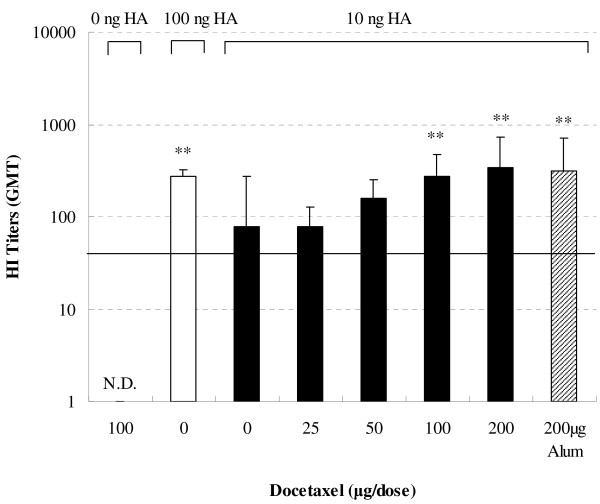
Serum HI titers. Mice (8 animals/group) were subcutaneously injected at weeks 0 and 3 with 100 μg docetaxel, inactivated H1N1 influenza virus antigen (equivalent to 10 or 100 ng HA) or inactivated H1N1 influenza virus antigen (equivalent to 10 ng HA) adjuvanted with docetaxel (25, 50, 100 or 200 μg). Blood samples were collected 2 weeks after the second immunization for hemagglutination inhibition test. Values represent geometrical mean titer (GMT) ± S.D. Significant differences with 10 ng HA group was designated as *P < 0.05 and **P < 0.01. N.D. indicates that HI titer was not detectable at the lowest dilution of serum. The solid horizontal line represents an HI titer of 40.